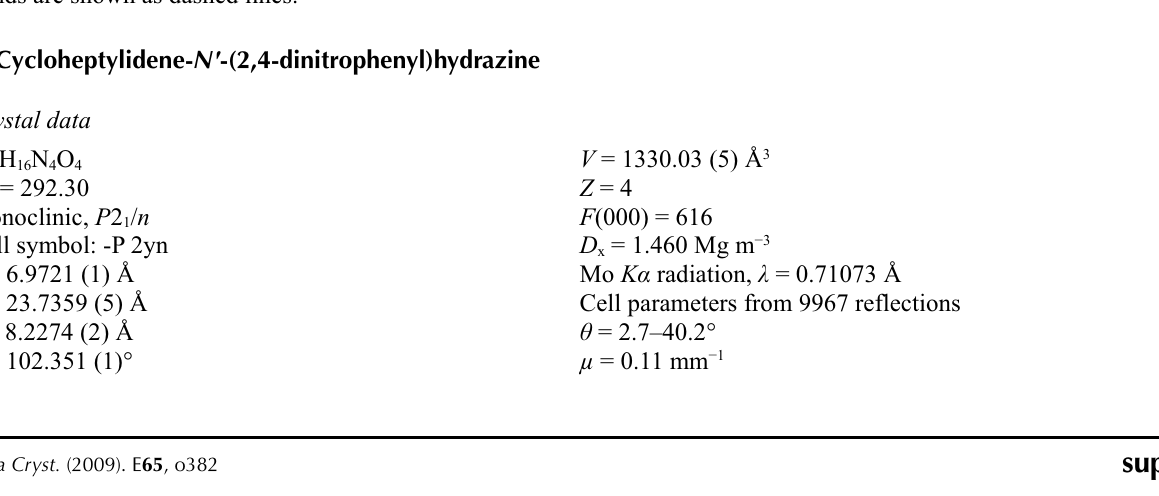
The crystal packing of the title compound, viewed down the c -axis showing dimer formation. Intermolecular hydrogen bonds are shown as dashed